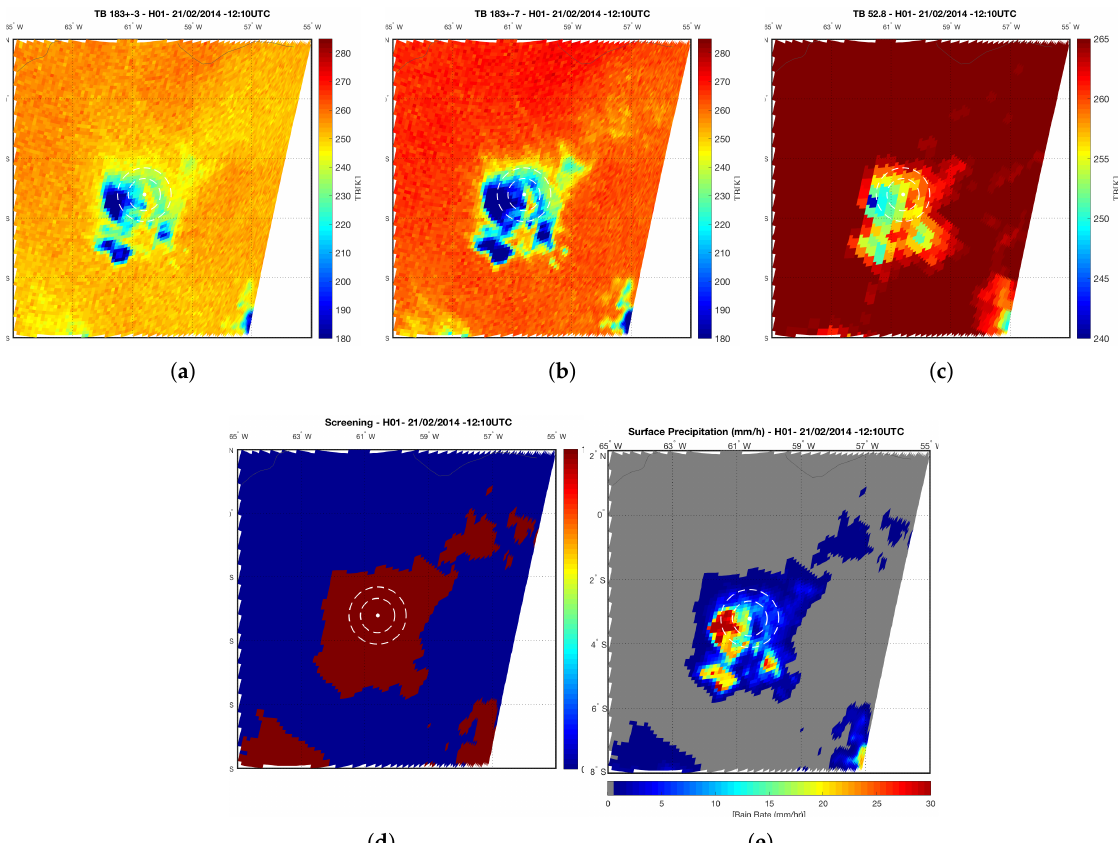
Figure 20. ( a ) TB 183 ± 3 GHz, ( b ) TB 183 ± 7 GHz, ( c ) TB 53 GHz, ( d ) Screening of precipitation (0—no rain, 1—rain) and ( e ) Surface Precipitation (mm/h) on 21 February 2014 at 12:10 UTC in the Manaus